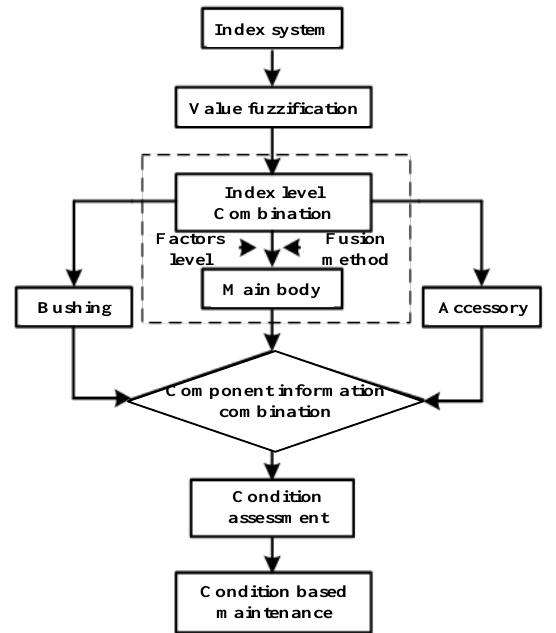
Figure 3. The flowchart of transformer condition assessment.